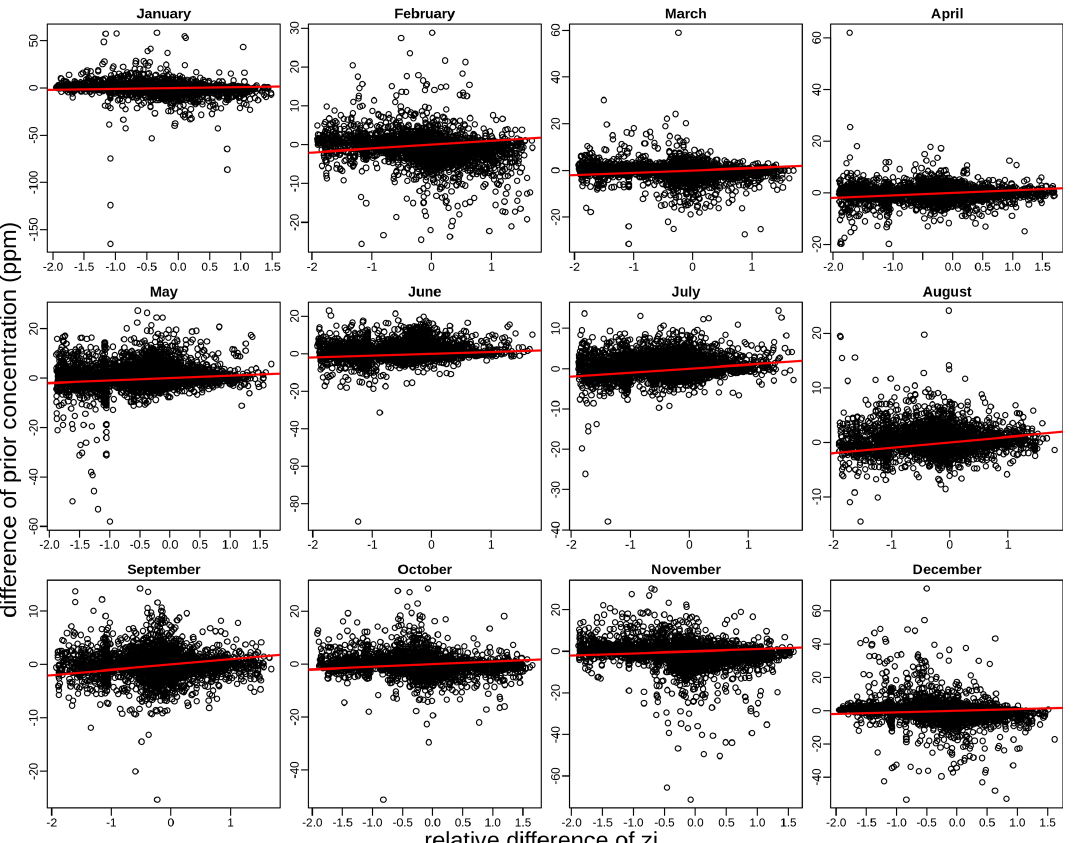
Figure 6. Scatter plot of differences of prior concentrations and mixing heights calculated with STILT and FLEXPART models (i.e. STILT- FLEXPART on the x and y axes). Red lines indicate the